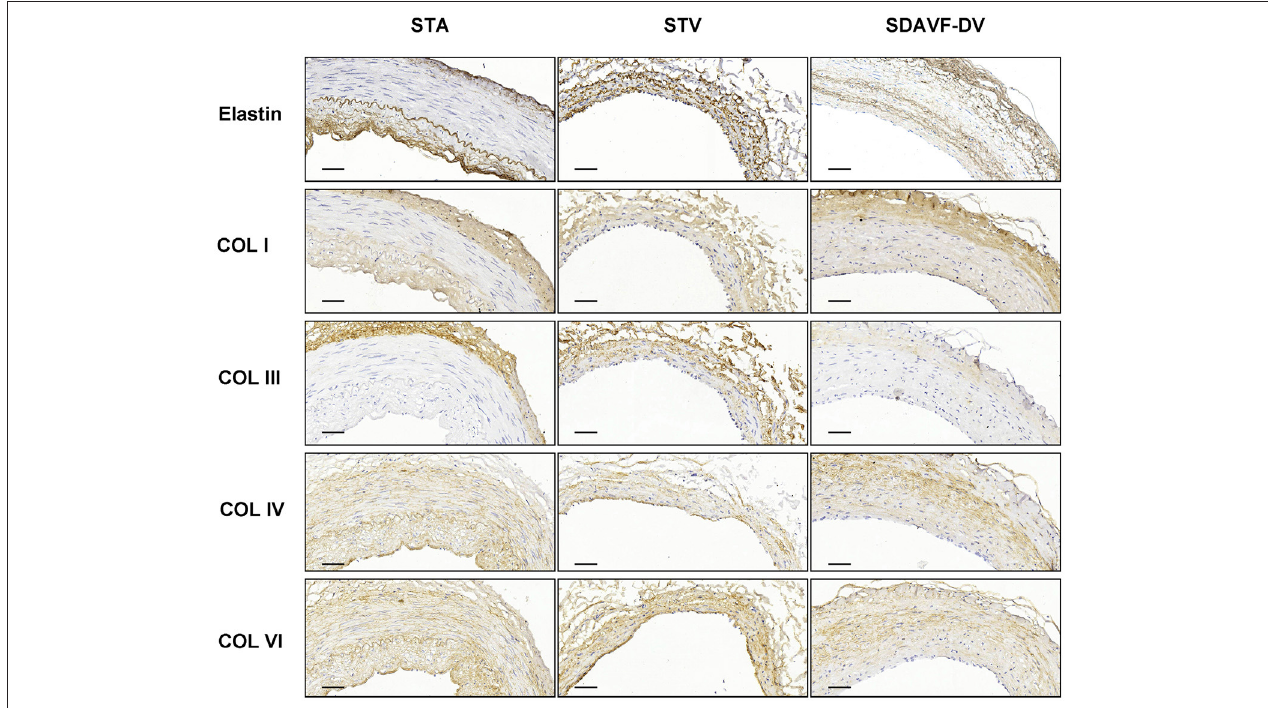
FIGURE 2 | Elastin, COL I, COL III, COL IV and COL IV immunohistochemistry. Histological features of the STA, STV and SDAVF-DV are shown in the photomicrographs. Representative photomicrographs showing HE-stained and Masson’s trichrome-stained vascular tissues are presented. Elastin, COL I, COL III, COL IV and COL IV were detected by immunohistochemistry. Scale bar = 50 µ m.